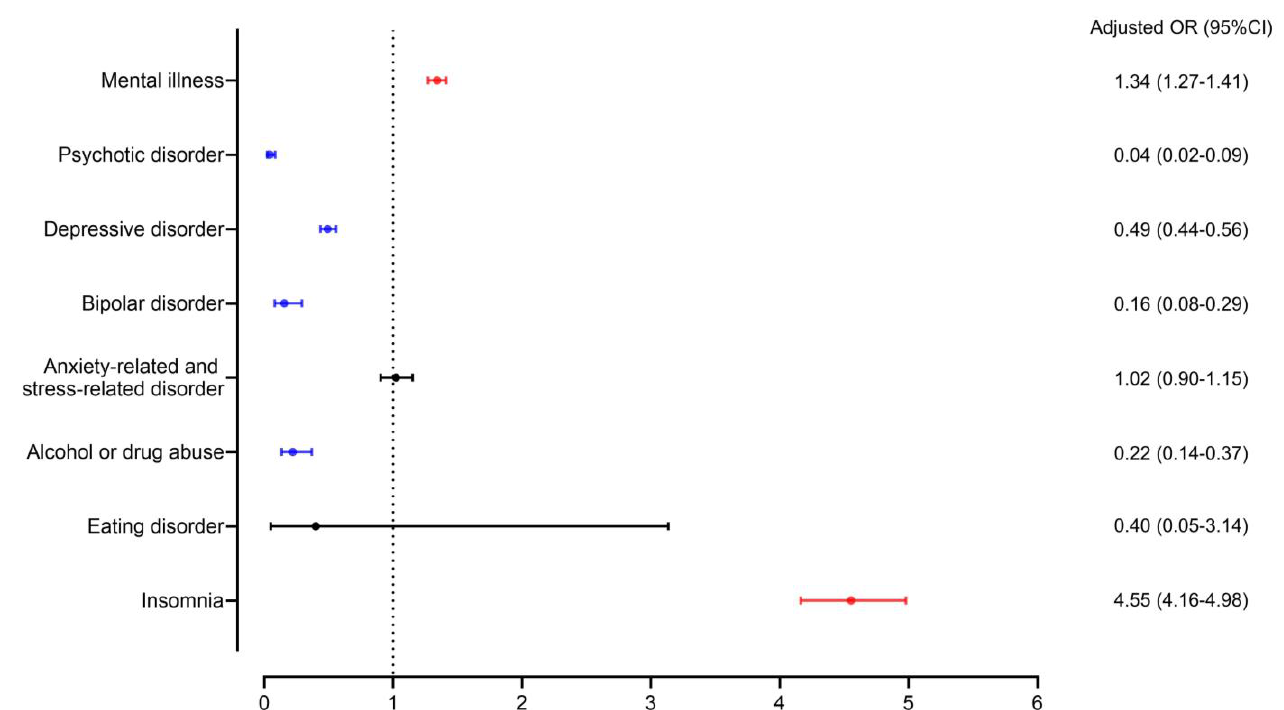
Figure 3. Propensity score-matched association of mental illnesses with hemifacial spasm